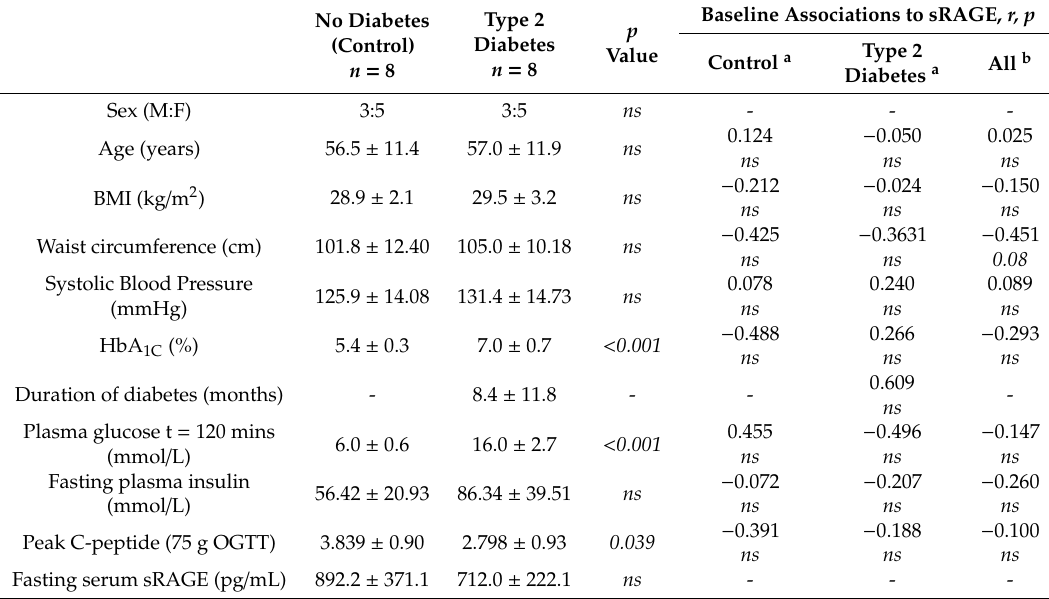
Table 1. Study participant anthropometric characteristics and their relationship with circulating sRAGE at baseline.